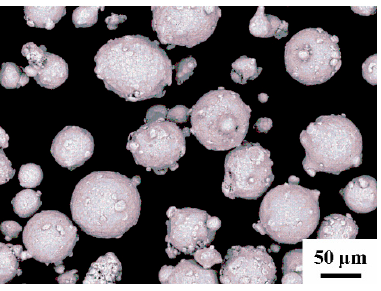
Figure 3. Scanning electron microscopy image of the 316L gas atomized powder used for preparing the selective laser melted 316L steel cellular dodecahedron structures.